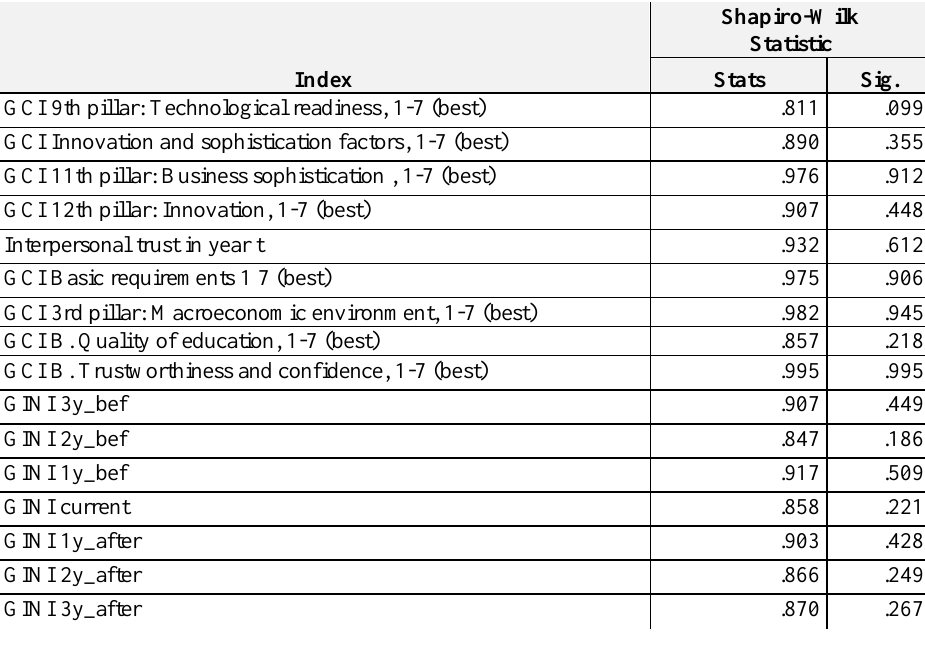
Table 1 Normality test